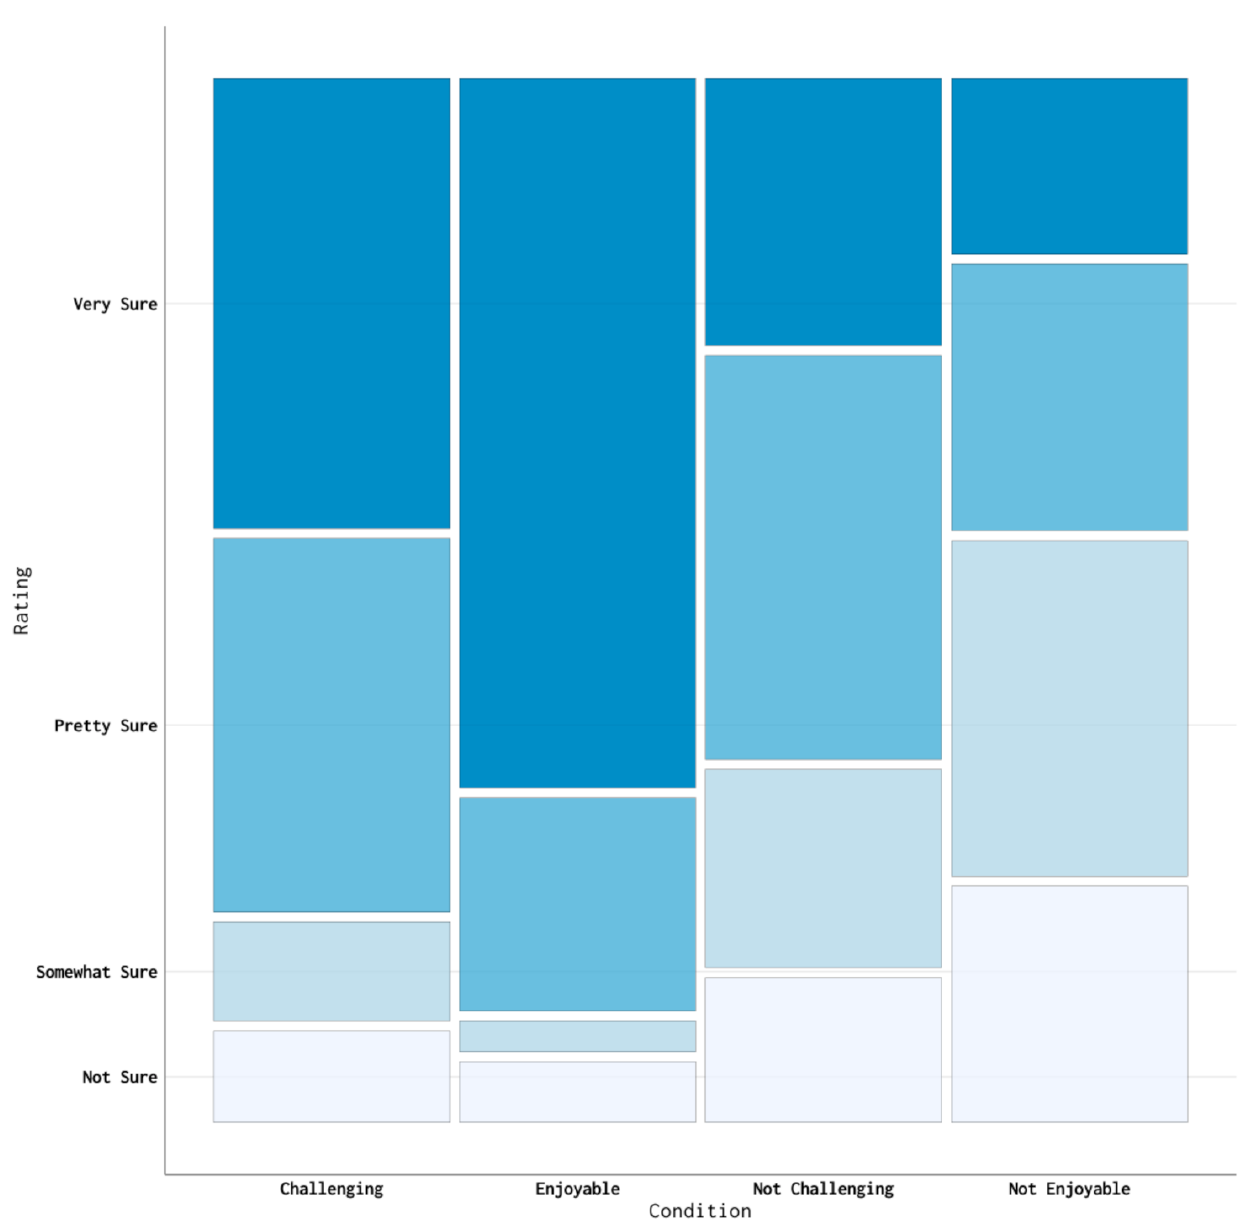
Figure 1. CogEx SES self-efficacy response ratings per condition across study